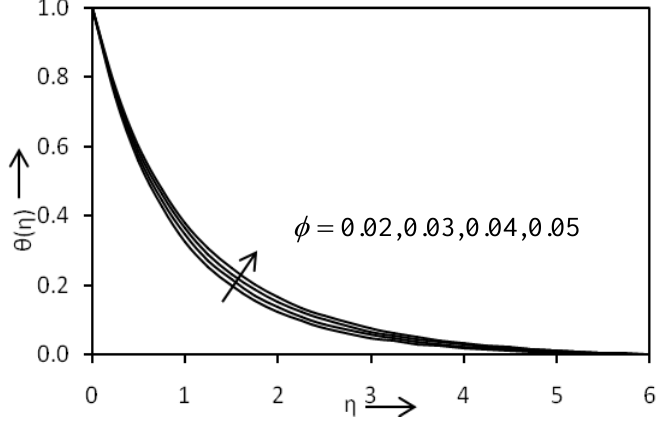
Figure 5. Variation of  on the temperature profiles with